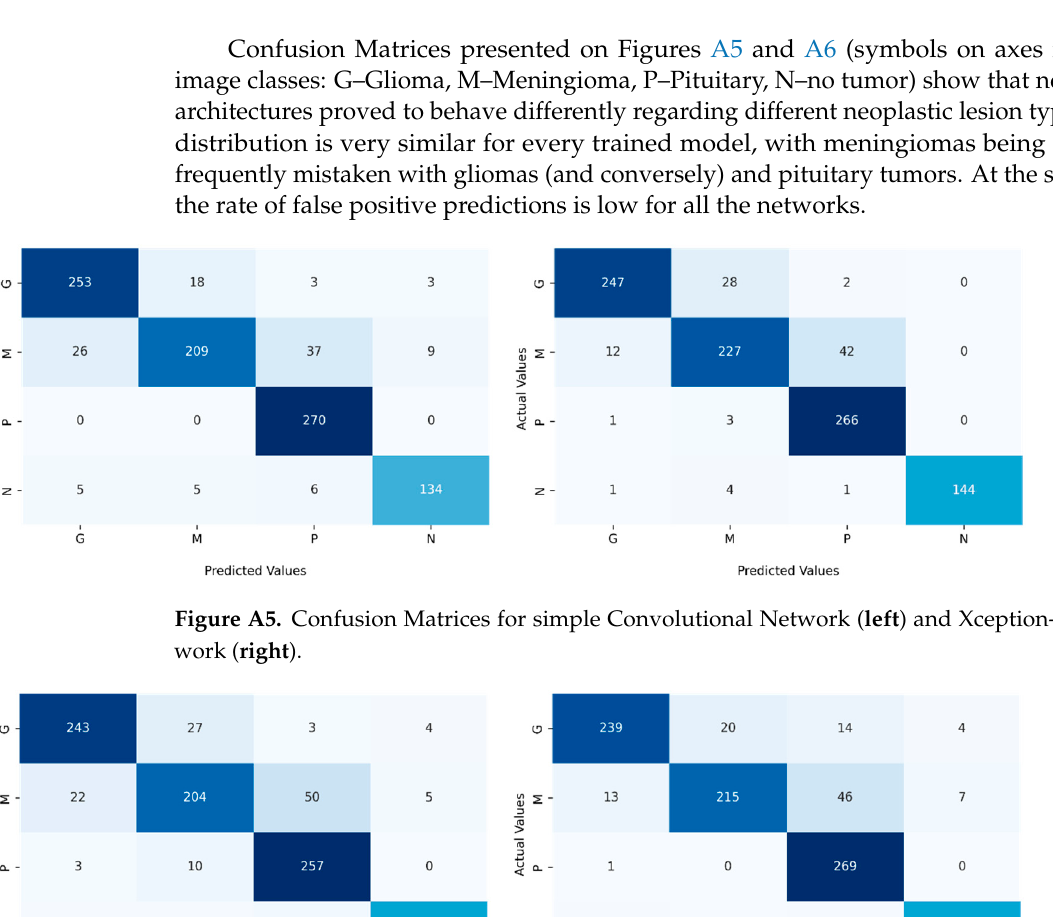
Figure A4. Training progress of the attention-based models: simple Vision Transformer ( left ) and pre-trained Vision Transformer ( right ).